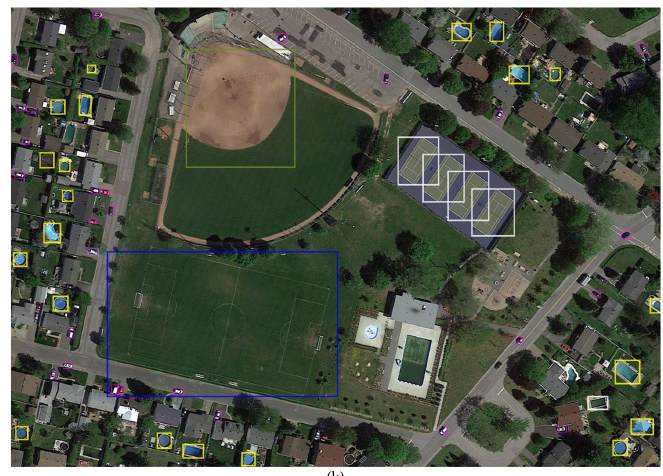
Figure 6. Visualization of the objects detected by SCFPN in the DOTA dataset. ( a ) swimming pool; ( b ) swimming pool, small vehicle, and roundabout; ( c ) small vehicle, large vehicle, basketball court, swimming pool, and tennis court; ( d ) bridge; ( e ) storage tank; ( f ) small vehicle; ( g ) plane and small-vehicle; ( h ) harbor; ( i ) boat, small vehicle, harbor, and swimming pool; ( j ) plane and helicopter; and ( k ) baseball diamond, tennis court, small vehicle, swimming pool, and soccer field.